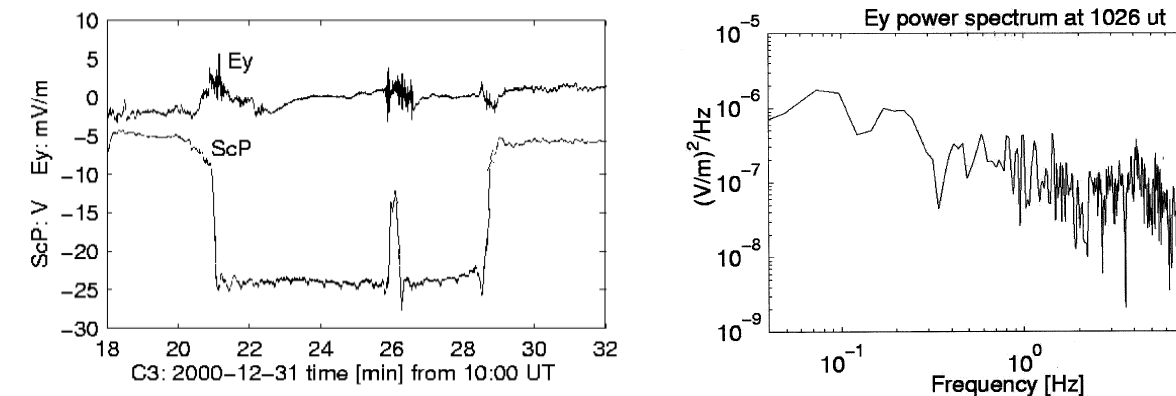
in the magnetosheath.